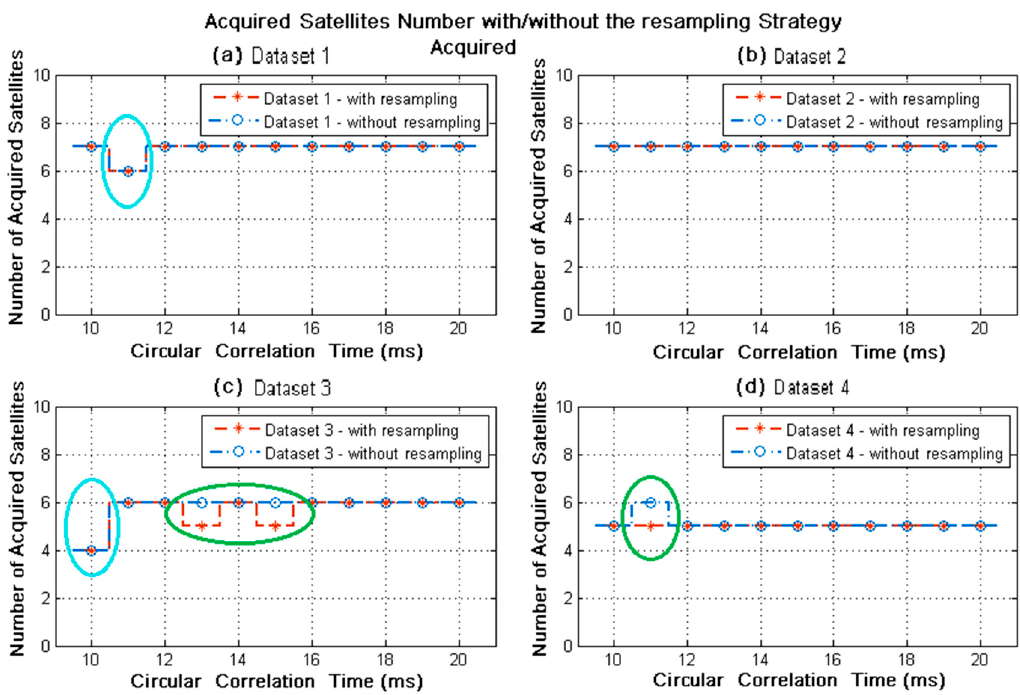
Figure 12. Number of satellites acquired without/with the resampling strategy for variable circular correlation time. The green circles indicate the difference of acquisition results without/with the resampling strategy; the cyan circles indicate the incomplete acquisition results with too short circular correlation time.